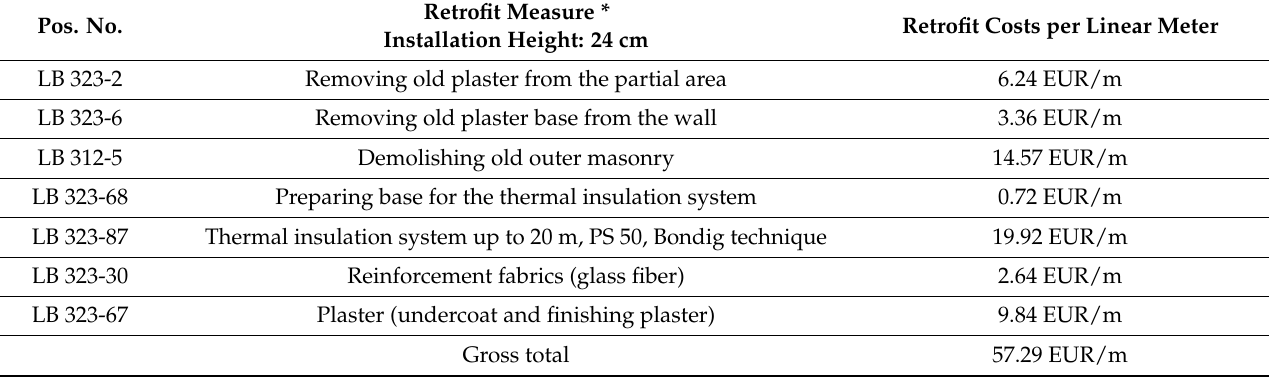
Table A8. Retrofit components and costs of the thermal bridge retrofit of an inside wall [38,39]. Pos. No.